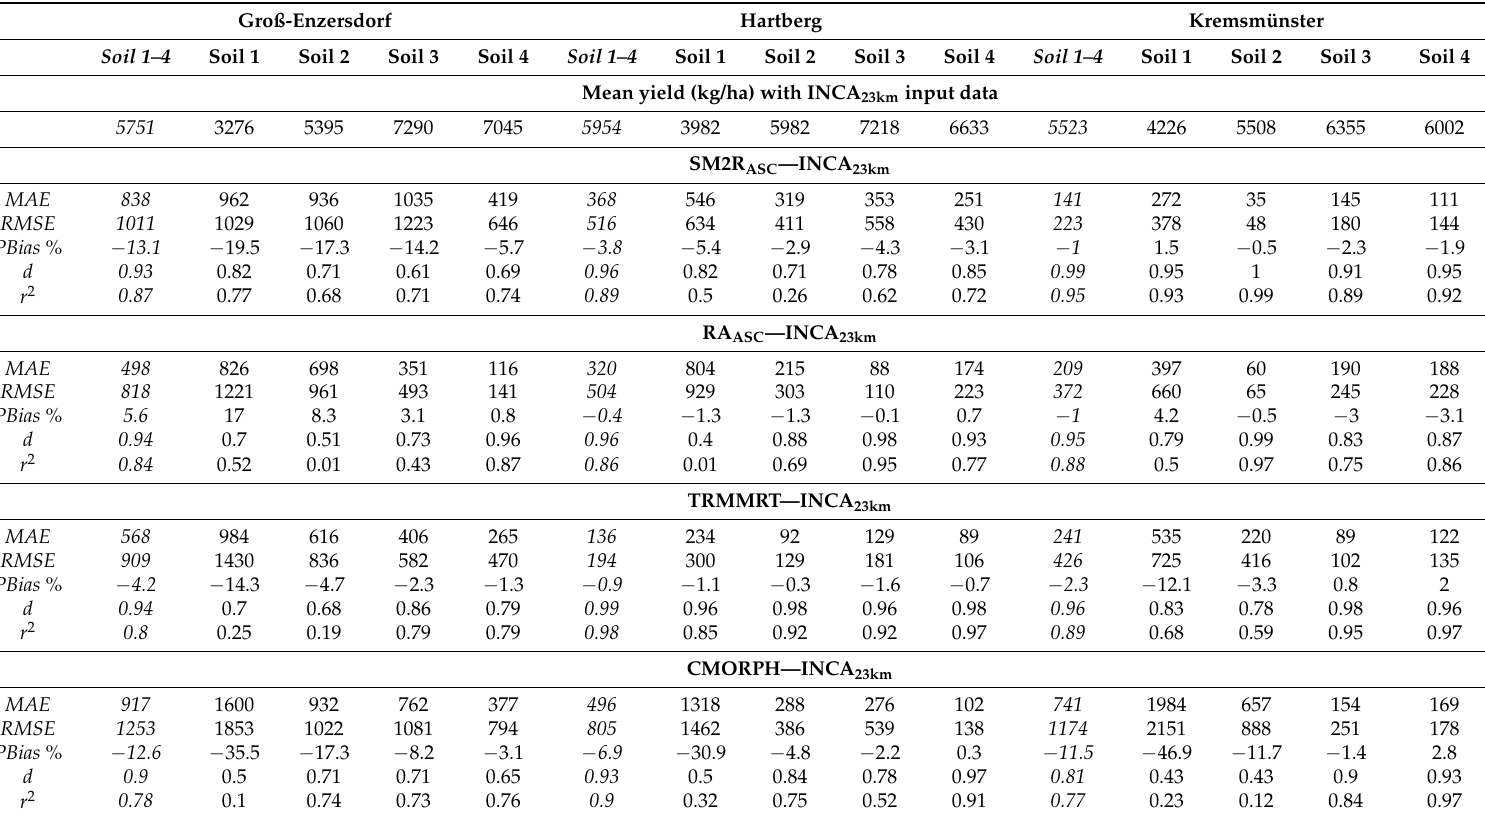
Table 7. Mean yield (kg/ha) with INCA 23km input data and comparative statistics ( RMSE , PBias , d and r 2 ) of model performance in simulated crop yield using SM2R ASC , RA ASC , TRMMRT and CMORPH precipitation inputs against INCA 23km inputs for the three study areas—winter